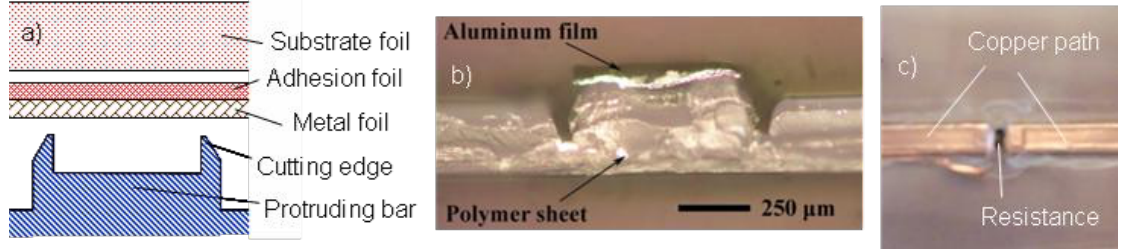
Figure 9. (a) Protruding structure on the tool with metal, adhesion, and substrate foils; (b) Cut through an aluminum conductor path on a PP foil; (c) SMD resistor embossed into PVDF and connected to copper conductor